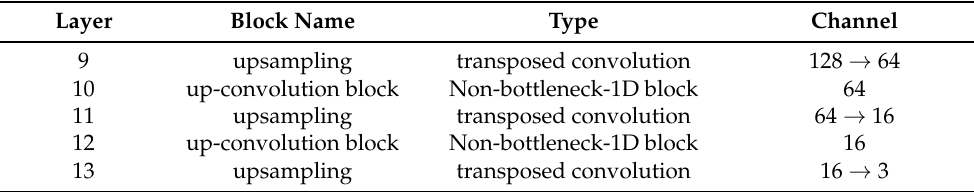
up-convolution block Non-bottleneck-1D